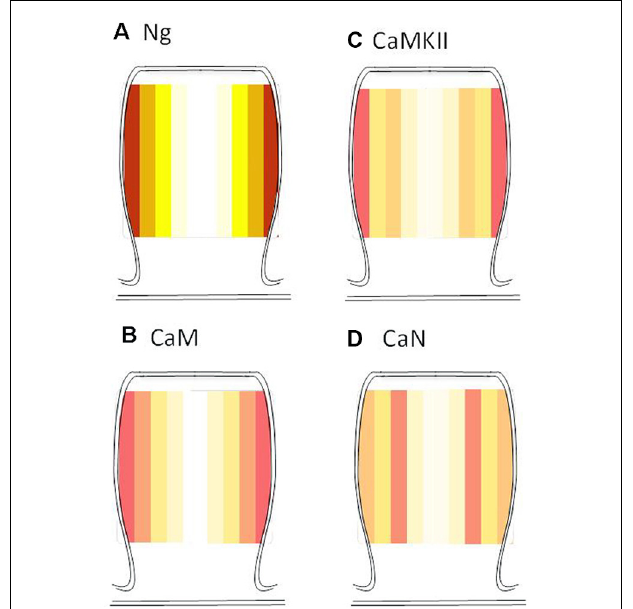
FIGURE 6 | Radial distribution of endogenous Ng, CaM, CaMKII, and calcineurin. Heat maps were generated based on the actual radial distribution of endogenous Ng (A) , CaM (B) , CaMKII (C) and calcineurin (D) from immuno-EM labeling. Note that while CaMKII, CaM, and Ng have their highest concentration close to the plasma membrane, calcineurin has its highest concentration away from the plasma membrane of the dendritic spines. Note: Ng and CaM heat maps were generated by re-analyzing immunoEM data from Zhong et al. (2009) and Zhong and Gerges (2012), respectively. FIGURE 7 | Ng and Metaplasticity. (A) Schematic diagram representing the